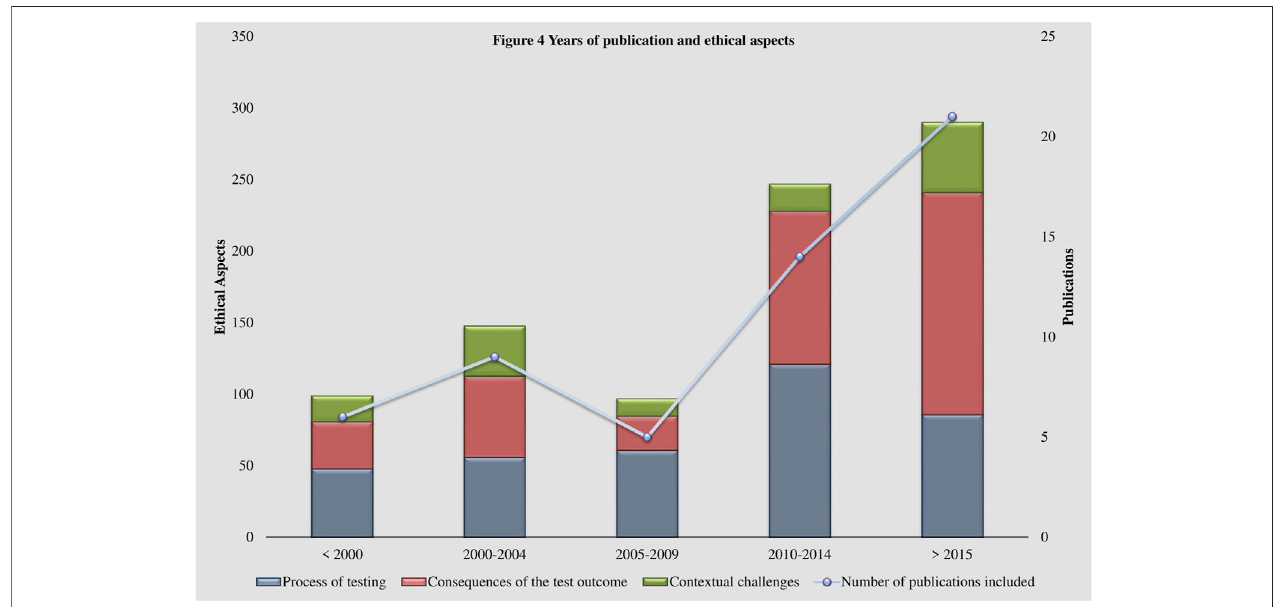
FIGURE 4 | Years of publication and ethical